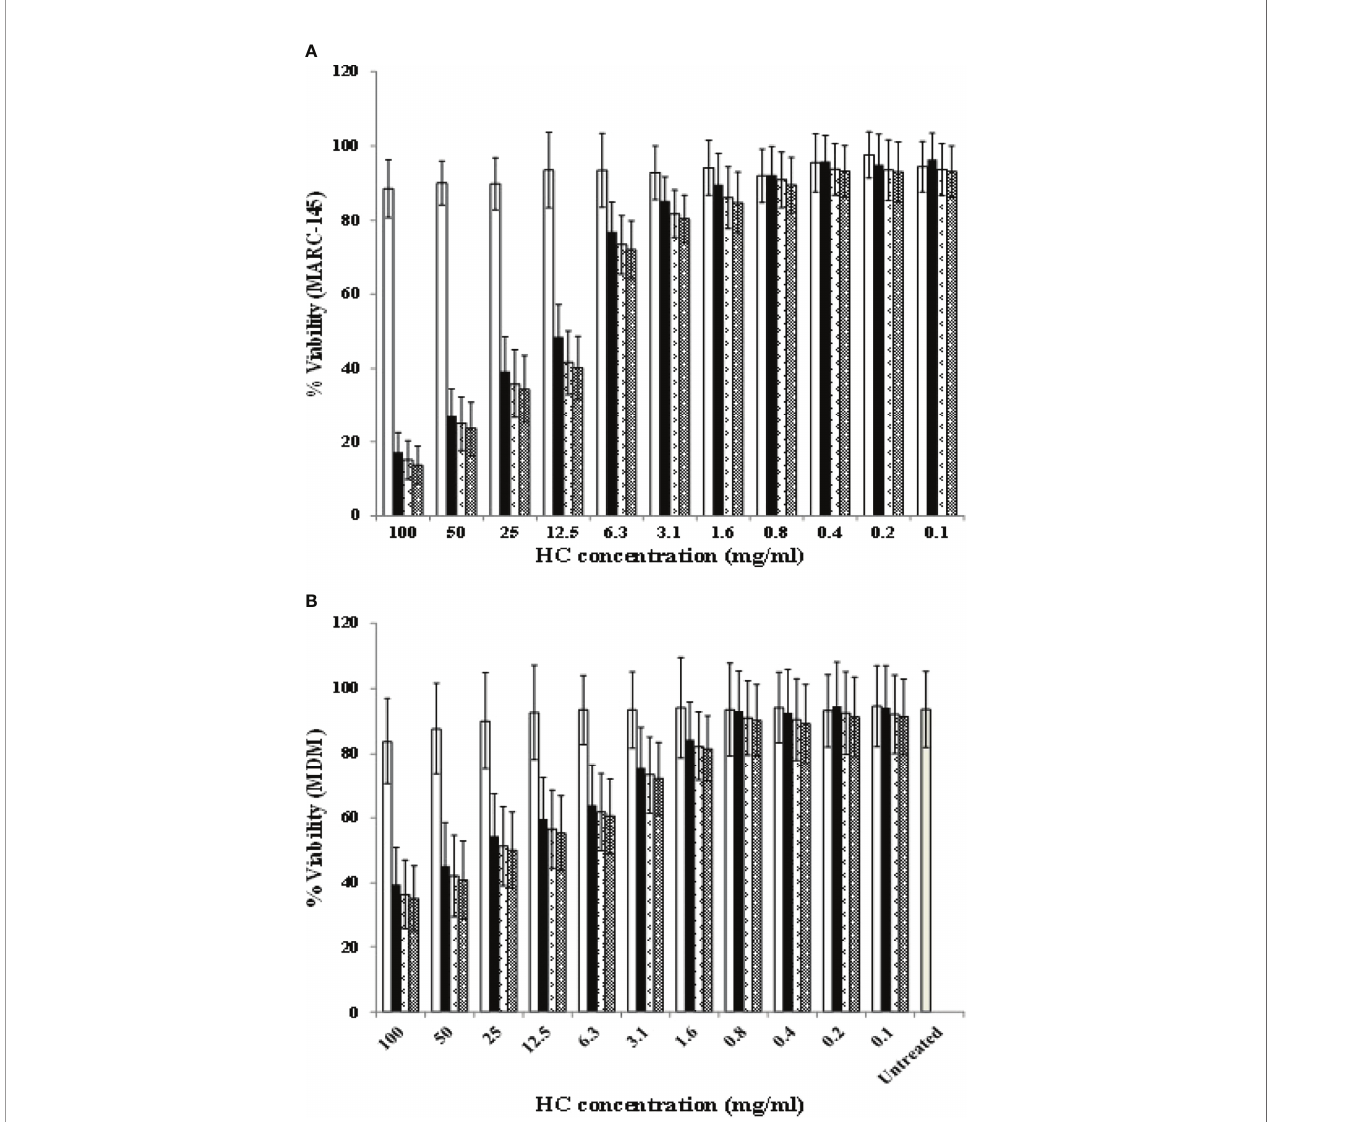
FIGURE 2 | Determination of non-cytotoxic concentration of HC50, HC70, and HC95. (A) MARC-145 cells were incubated with 2-fold serially diluted HC50 (black bar), HC70 (divot bar), and HC95 (dotted bar), each starting at a fi nal concentration of 100 mg/ml for 96 h. The cultures were then fi xed with acetone:methanol solution, and stained with 0.5% crystal violet and Sorenson ’ s buffer. MARC-145 cells incubated with vehicle solution served as vehicle control (white bar). The O.D. values obtained from MARC-145 cells treated with HC50, HC70, HC95, and vehicle solution were compared with those from MARC-145 cells incubated with only MEM ++ (untreated control) and expressed as %viability. (B) MDMs ( n = 4 pigs) were incubated with 2-fold serially diluted HC50 (black bar), HC70 (divot bar), and HC95 (dotted bar), each starting at a fi nal concentration of 100 mg/ml for 36 h. The cultures were then harvested and stained with trypan blue. MDMs incubated with vehicle solution served as vehicle control (white bar). Error bar indicates the standard deviation